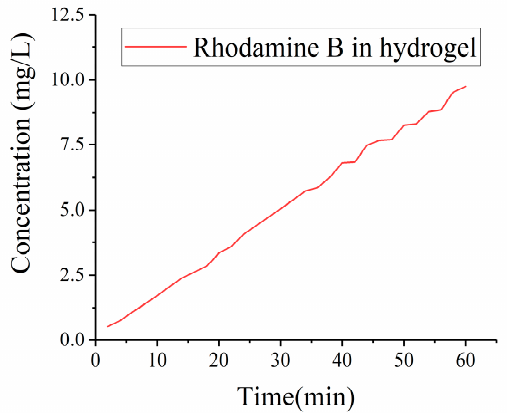
Figure 9. Fluorescence pictures of MNs with rhodamine B stuck into artificial skin without rhodamine B: ( a ) the moment MNs was stuck into artificial skin; ( b ) the MNs had been stuck into artificial skin for 1 h. The scale bar is 200 µm.